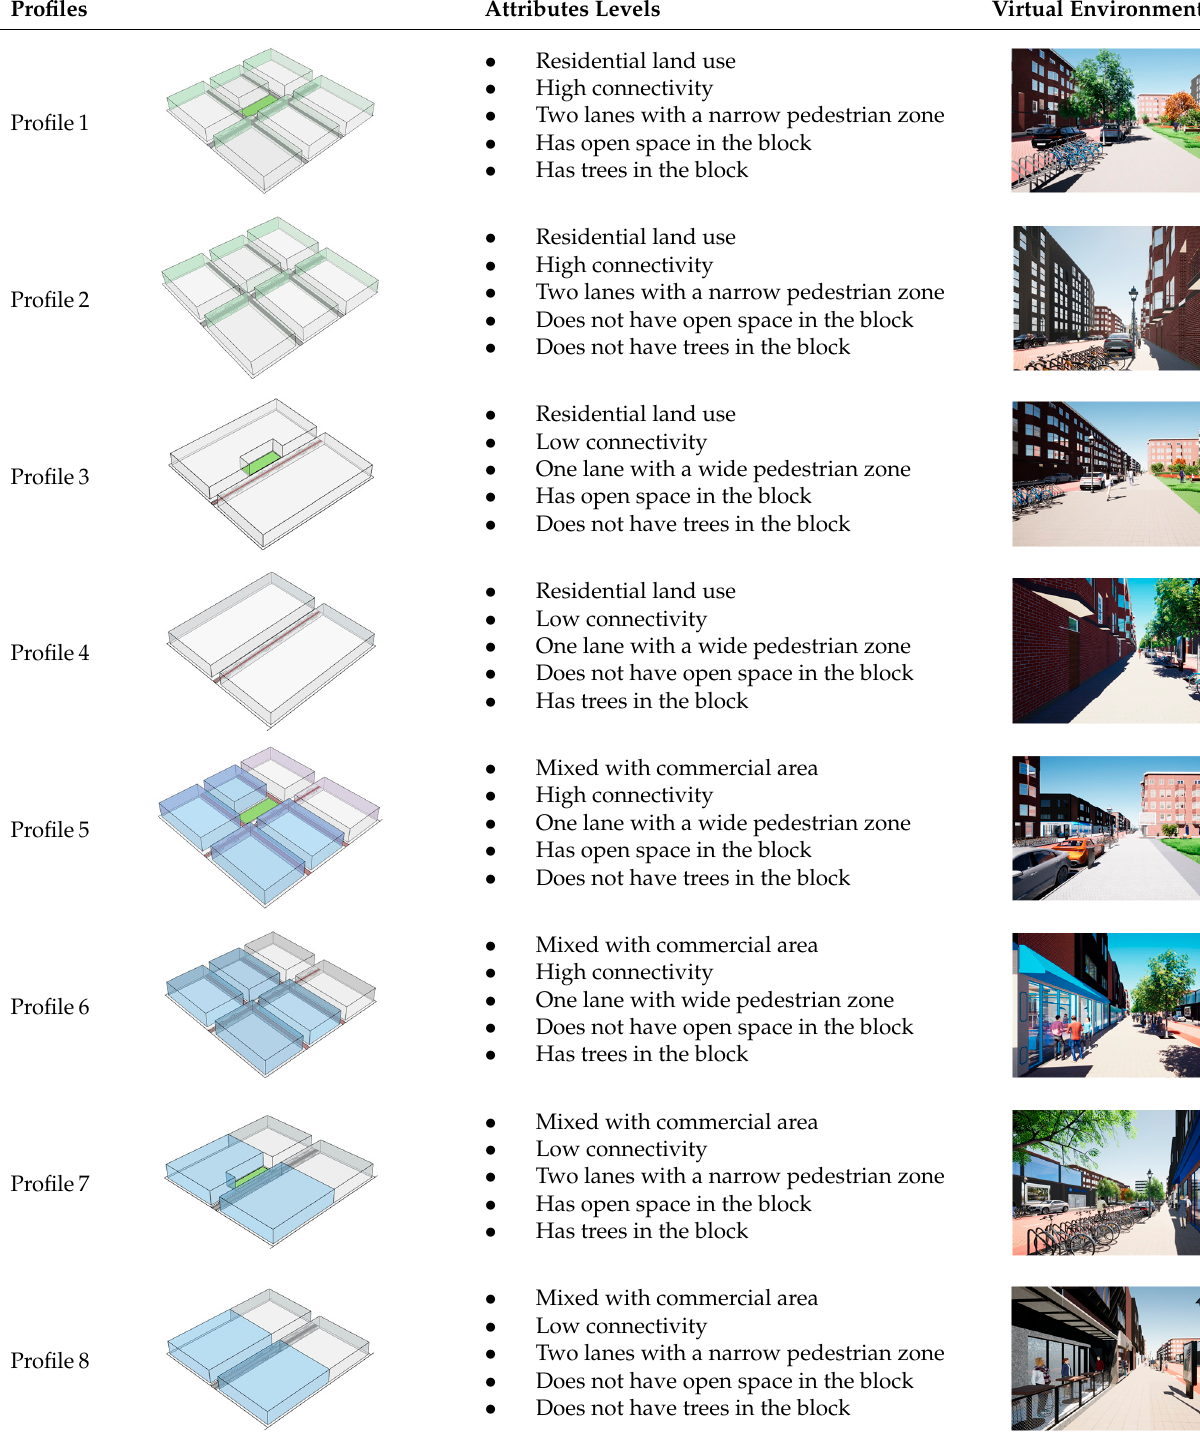
Table 1. The design profiles of the conjoint experiment.